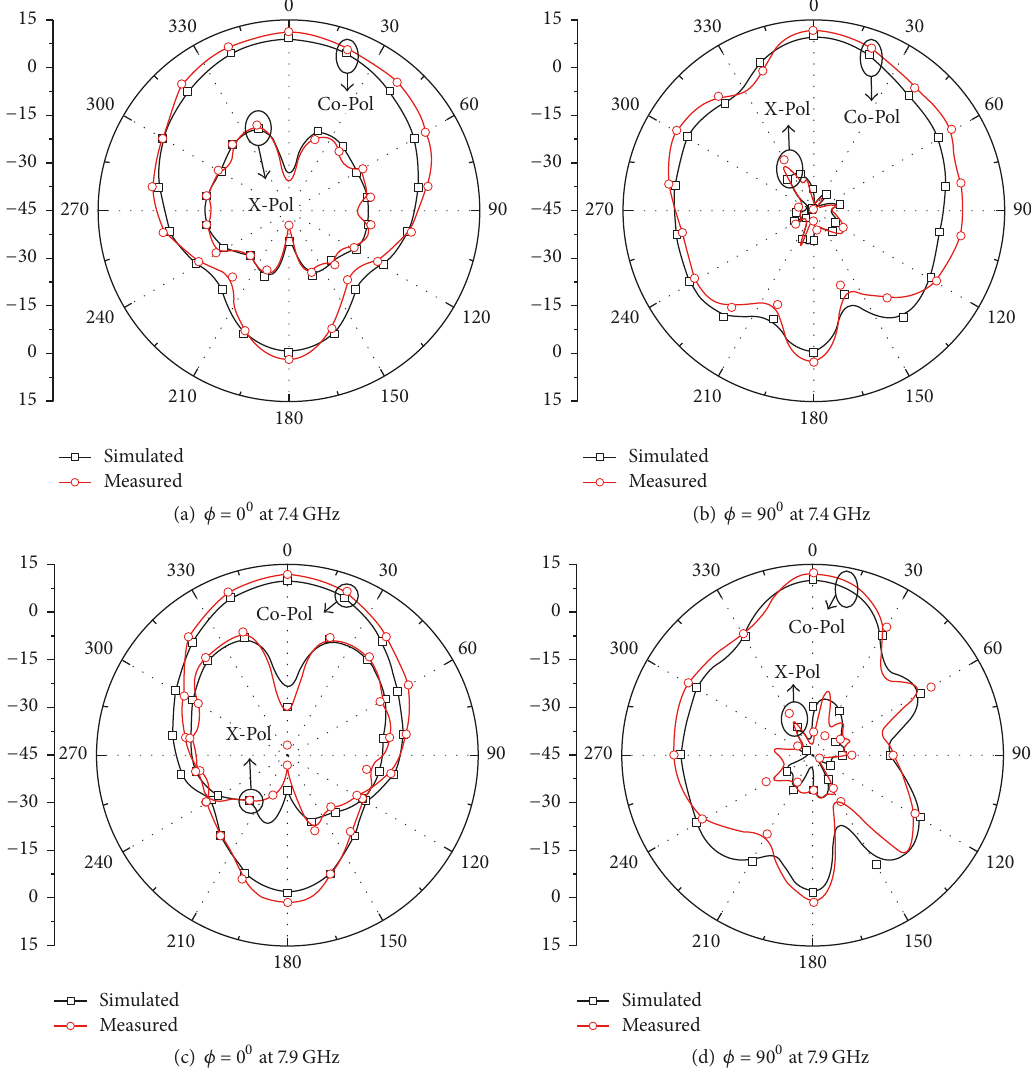
Figure 15: Measured and simulated gain radiation